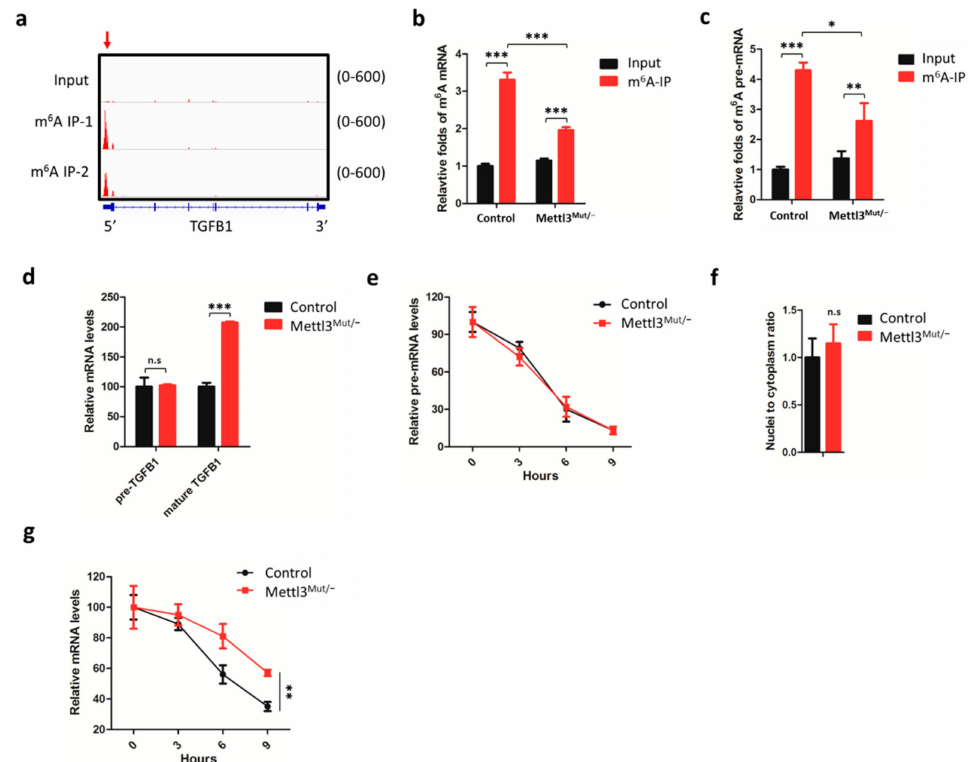
Figure 2. m 6 A triggers TGFB1 mRNA decay in HeLa cells. ( a ) m 6 A peaks were enriched in the 5 (cid:48) UTR and CDS regions of TGFB1 mRNA from m 6 A RIP-seq data. Arrows marked the m 6 A peaks in HeLa cells. The m 6 A abundance of TGFB1 mRNA is listed on the right; ( b ) m 6 A RIP-qPCR analysis of TGFB1 mature mRNA in control and Mettl3 Mut / − HeLa cells. Input samples were total RNA extracted from control and Mettl3 Mut / − HeLa cells. Relative folds of TGFB1 mRNA in m 6 A RIP samples were normalized to the input of control cells; ( c ) m 6 A RIP-qPCR analysis of TGFB1 precursor (pre-) mRNA in control and Mettl3 Mut / − HeLa cells. Relative folds of TGFB1 pre-mRNA in m 6 A RIP samples were normalized to the input of control cells; ( d ) expression levels of precursor (pre-) and mature mRNA of TGFB1 in control and Mettl3 Mut / − HeLa cells were measured by qRT-PCR; ( e ) Control and Mettl3 Mut / − HeLa cells were incubated with 5 µ g / mL Act-D for indicated times. Expression levels of TGFB1 pre-mRNA were measured by qRT-PCR; ( f ) TGFB1 mRNA levels in nuclear and cytoplasmic fractions from control and Mettl3 Mut / − HeLa cells were measured by qRT-PCR. Localization of TGFB1 mRNA was calculated as nuclear abundance divided to cytoplasmic abundance; ( g ) Control and Mettl3 Mut / − HeLa cells were incubated with 5 µ g / mL Act-D for indicated times. Expression levels of TGFB1 mRNA were measured by qRT-PCR. Data are presented as means ± SD from three independent